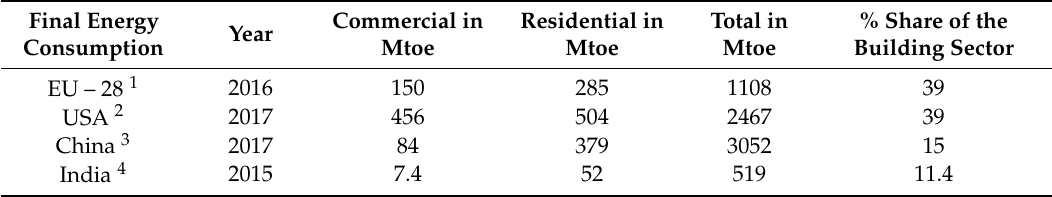
Table 3. Energy consumption of the building sector.